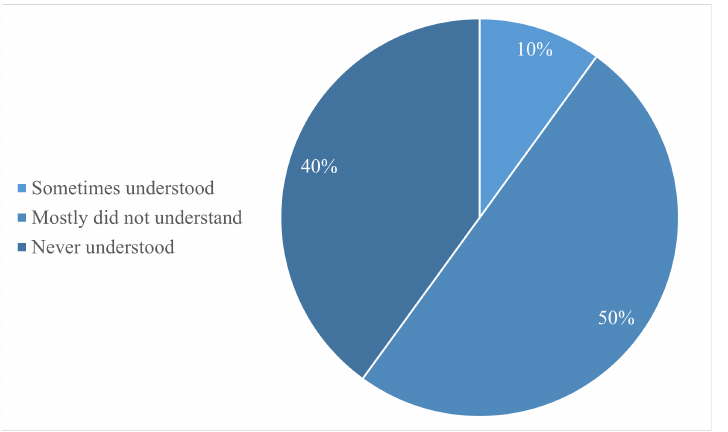
Figure 24. Answers to the question “How well did you understand where/how to place the components on the assembly?”.